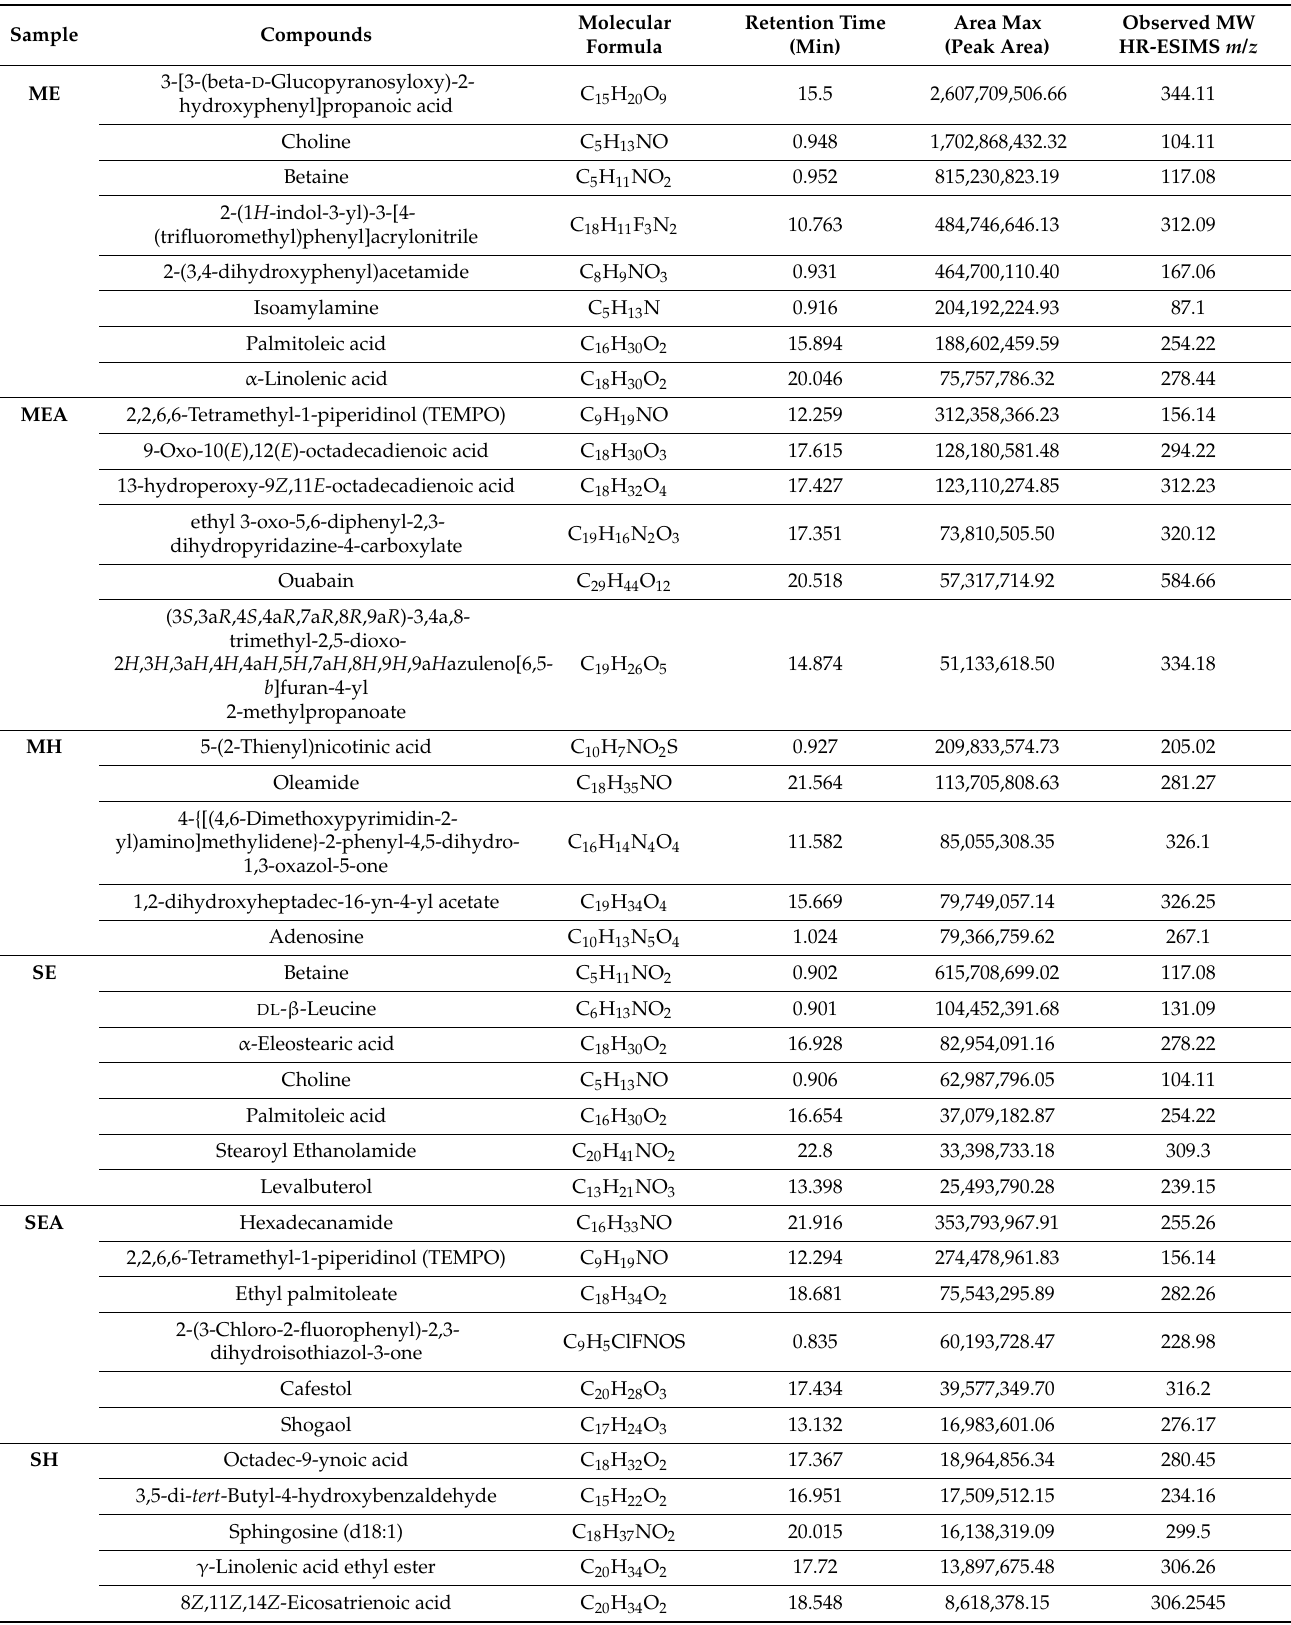
Table 1. Metabolites profile observed in C. lentillifera from HPLC-ESI-HRMS/MS